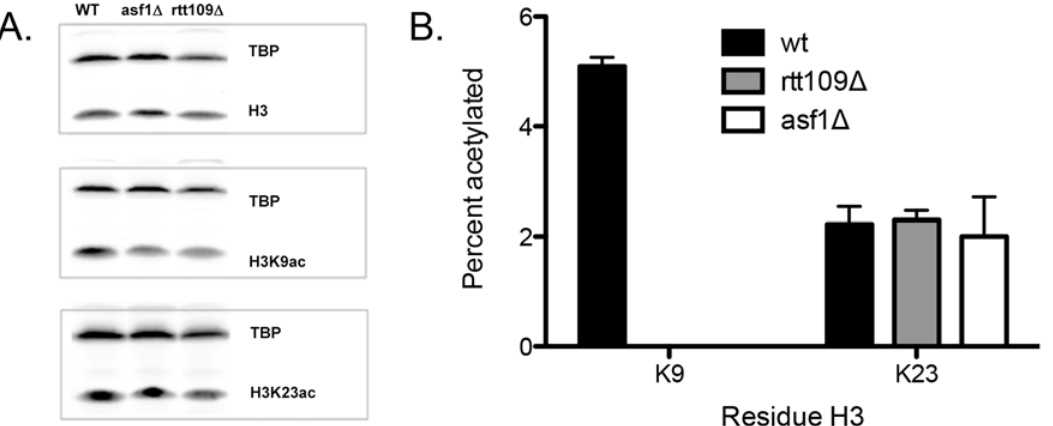
Fig 6. Changes in vivo due to the loss of either Rtt109 or Asf1. (A) Western blots using antibodies for H3, H3K9 or H3K23, using whole cell extracts from wild type (wt), rtt109 Δ , and asf1 Δ strains. (B) Determination of the percentage of acetylation at position H3K9 or H3K23 in wt, rtt109 Δ , and asf1 Δ strains using the targeted MS-based method. The error bar represents the standard error in acetylation